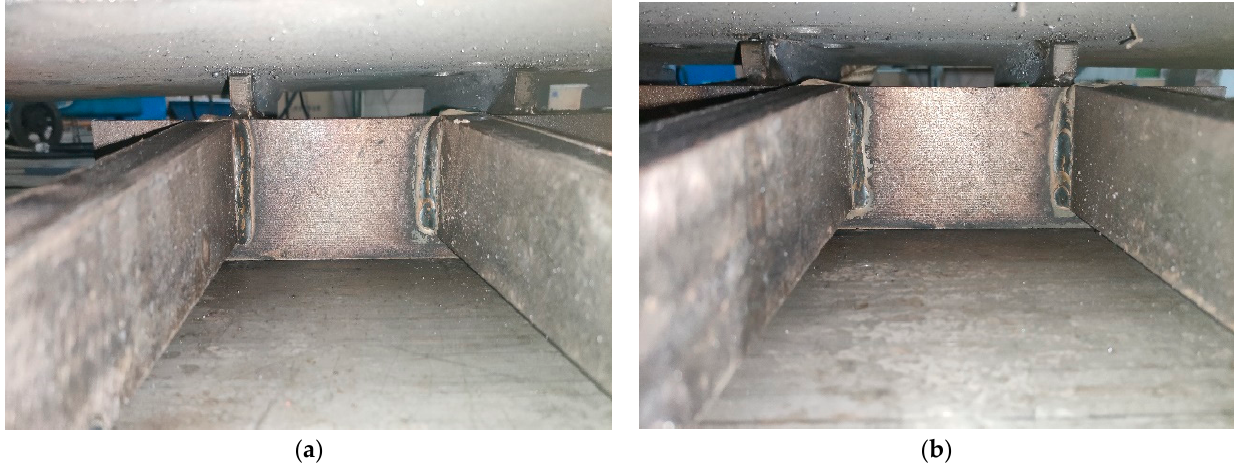
Figure 24. Welds of fixed comb plate and support system:( a ) From top to bottom in Figure 22b, below the third teeth, ( b ) Below the fourth teeth.